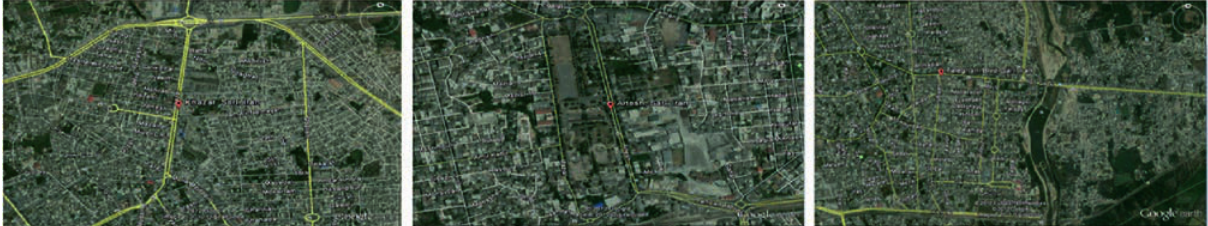
Fig. 2. The view of three boulevards in Sari: a – Khazar Boulevard (KB); b – Artesh Boulevard (AB); c – Taleghani Boulevard